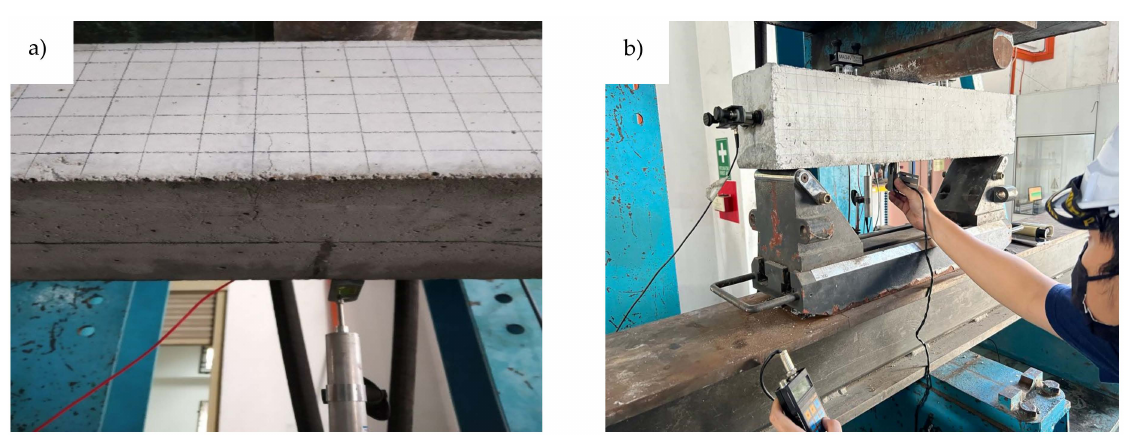
Figure 5. ( a ) The location of scanning pathway ( b ) scanning of the beam after it is subjected to cyclic